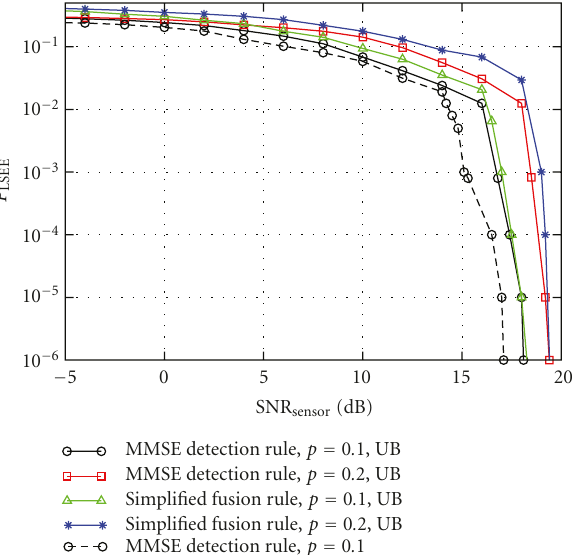
Figure 8: Probability of LSEE, as a function of the sensor SNR, for the same cases shown in Figure 5. For the MMSE case with p = 0 . 1, the exact performance and the UB are shown. For the other cases, only the UBs are